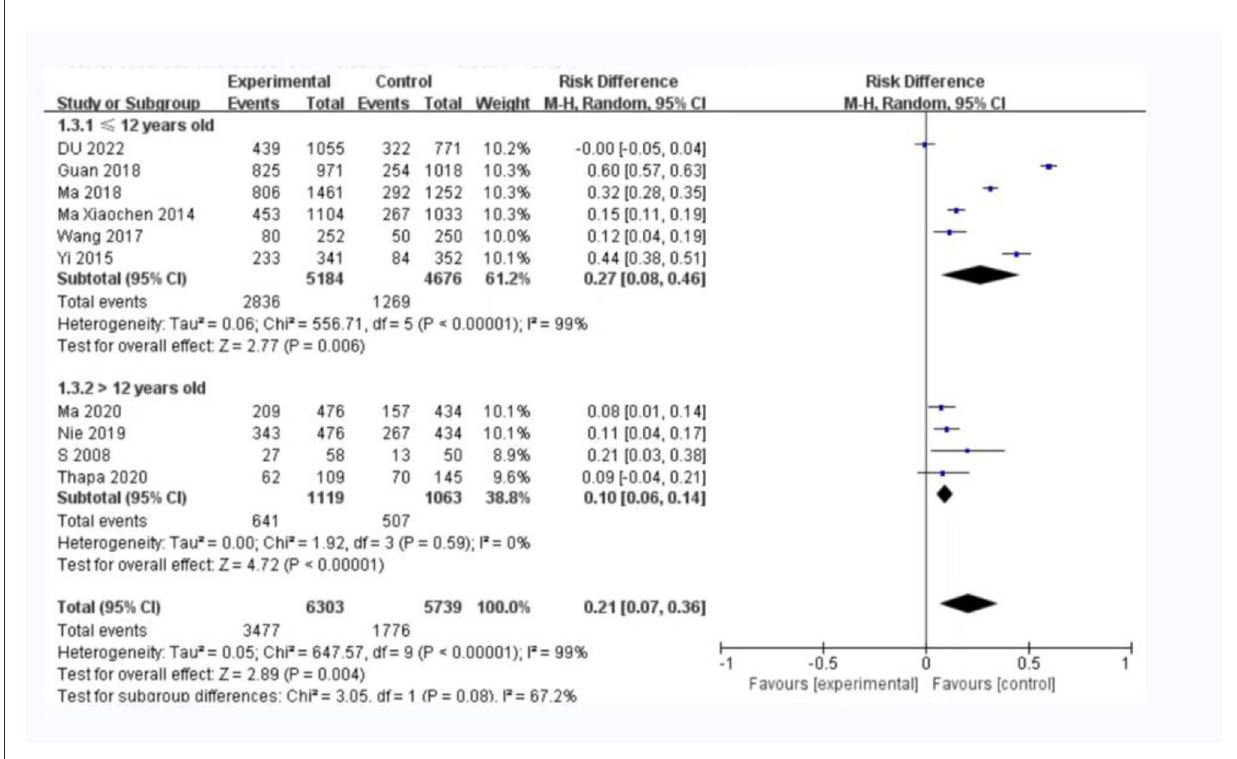
FIGURE6 A subgroup analysis of the mean age of the participants.